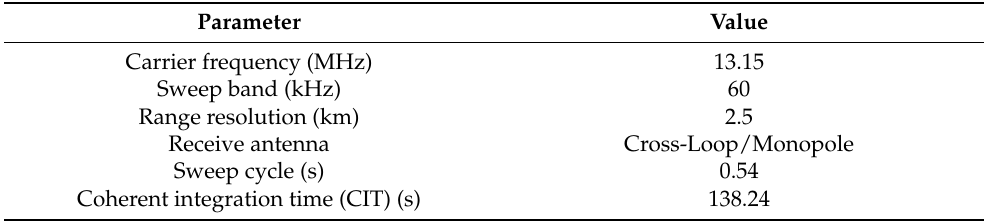
Table 1. Parameters of OSMAR-SD.